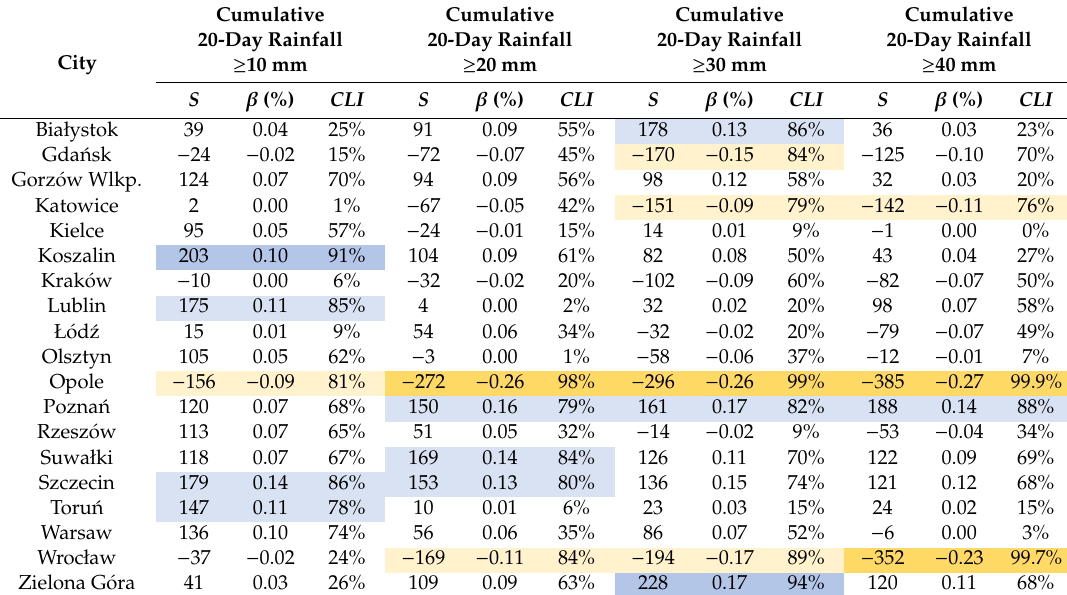
Table 4. Trend detection parameters for 20-day cumulative rainfall for the di ff erent thresholds under study, during the period